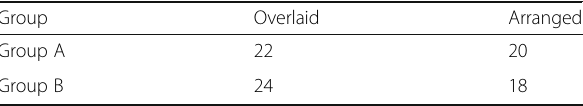
Table 2 Total number of participants who accurately explained the types of streamlines that are selected Group Overlaid Arranged Group A